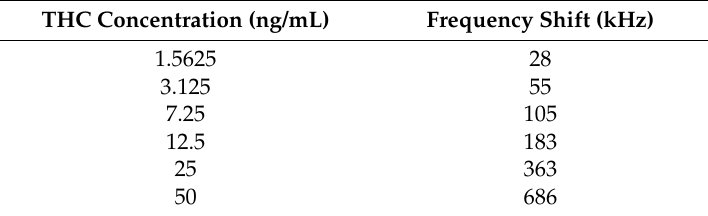
Figure 8. Measurement results of the FPW readout system prototype. Table 3. The frequency shifts of the FPW-based THC biosensors are measured under six concentrations.